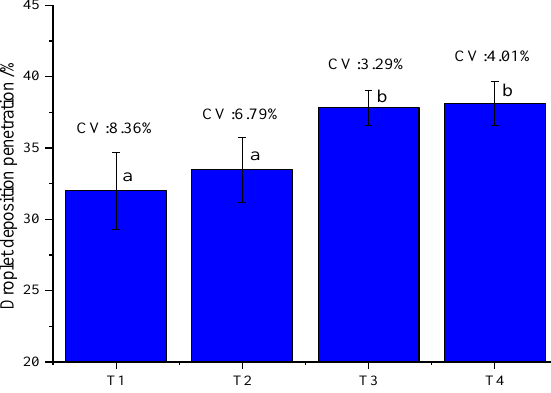
Figure 8. Average droplet deposition penetration in target area. Bars with different letters are significantly different, Duncan’s test, p -level < 0.05.